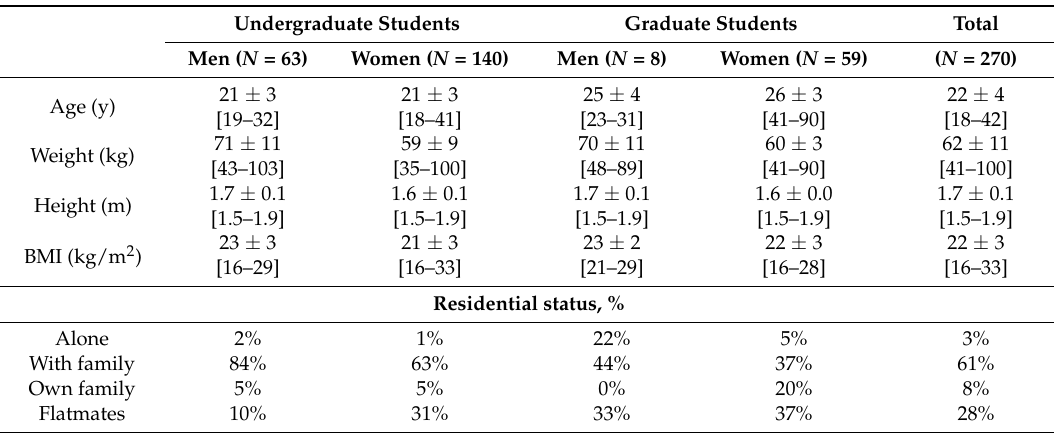
Table 5. Sociodemographic characteristics of participants who completed the study. Values are expressed as mean ± SDM, as well as the range (in squared brackets), and the proportion for anthropometrical and demographic